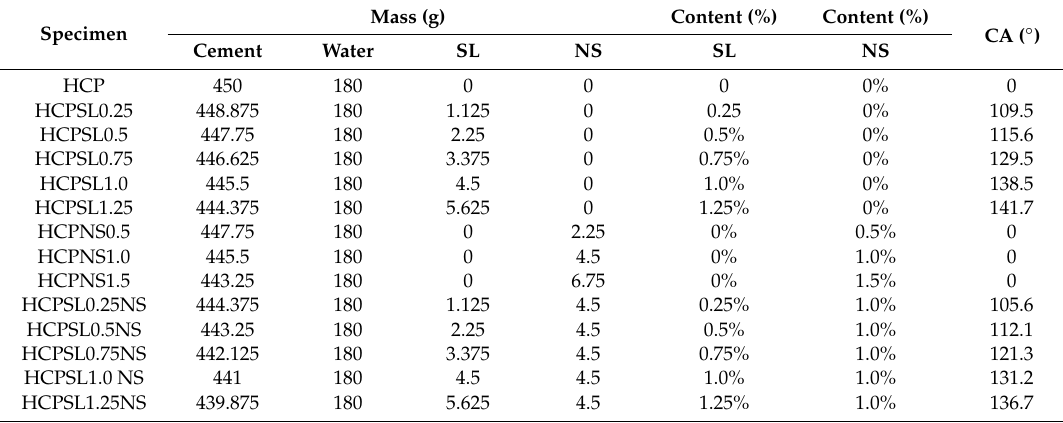
Table 1. The formulation of cement pastes modified with sodium laurate (SL) and nano silica (NS).